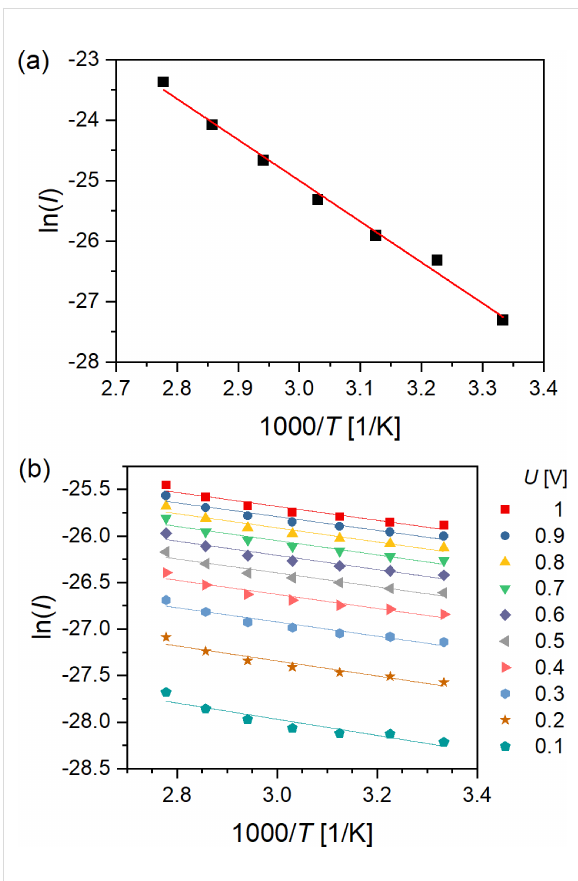
Figure 4: Arrhenius plots. (a) Ru(TP) 2 -complex wire device ( U = 1 V). (b) Ru(MPTP) 2 –AuNP device for voltages between 0.1 and 1 V. Points correspond to measurements while lines correspond to linear regres-